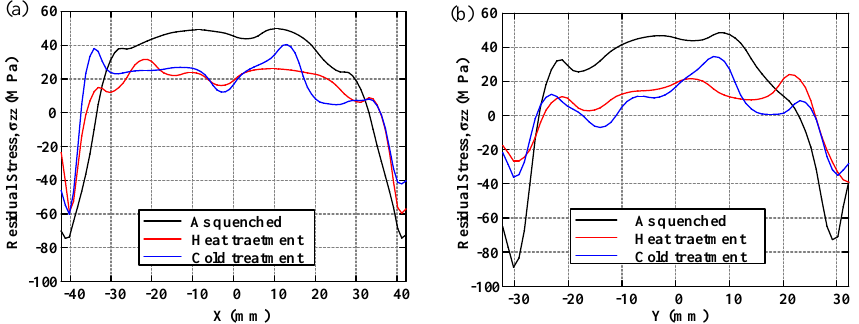
Figure 9. Short-transversal residual stresses ( σ yy ) on cut plane 3 in three different conditions: ( a ) as- quenched specimen; ( b ) heat-treated specimen; ( c ) cold-treated specimen. (The specific reconstruction process is omitted.)